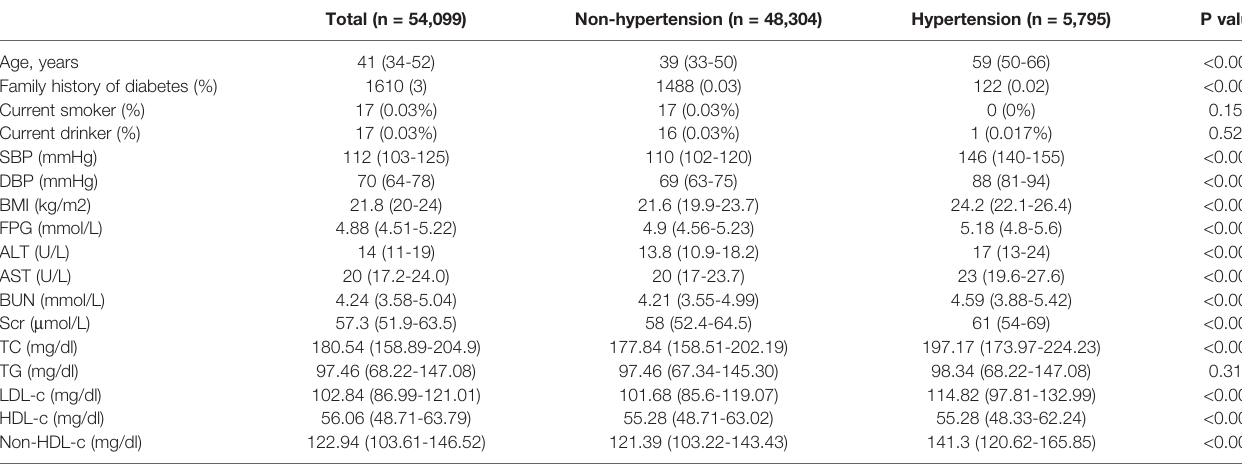
TABLE 1 | Baseline information of the adult